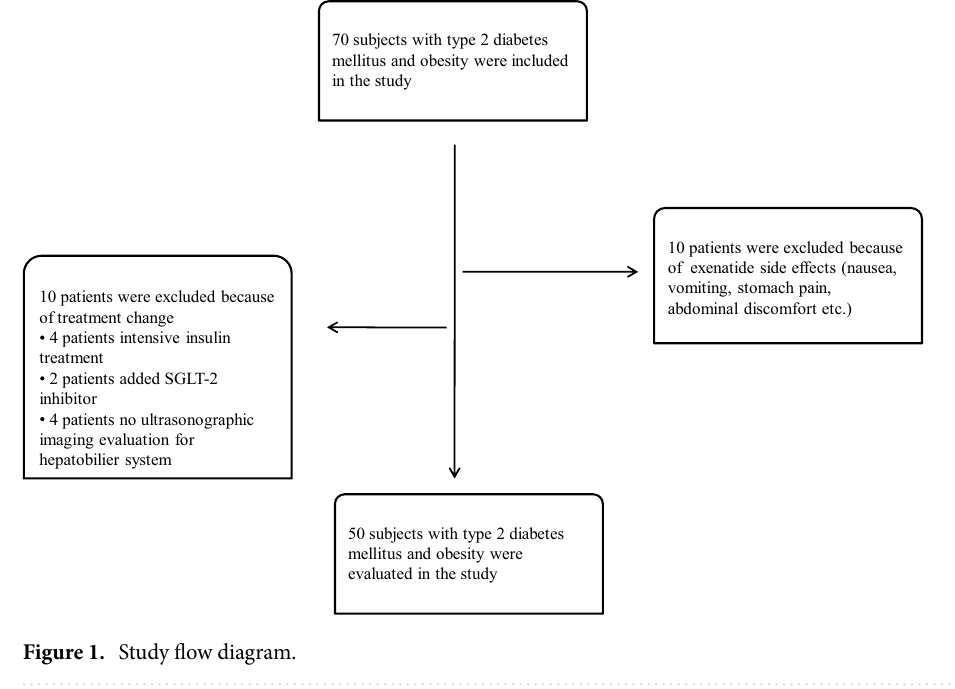
Figure 1. Study flow